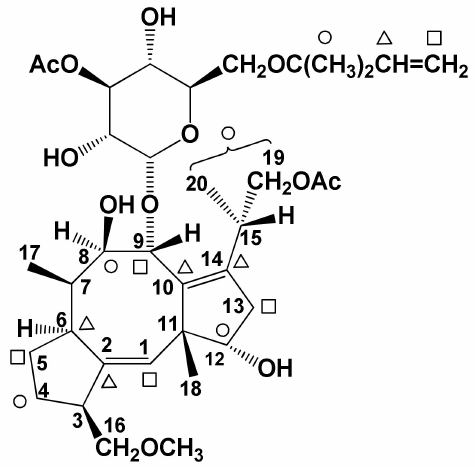
Figure 4. 3 H and 14 C incorporation sites in radiolabeled